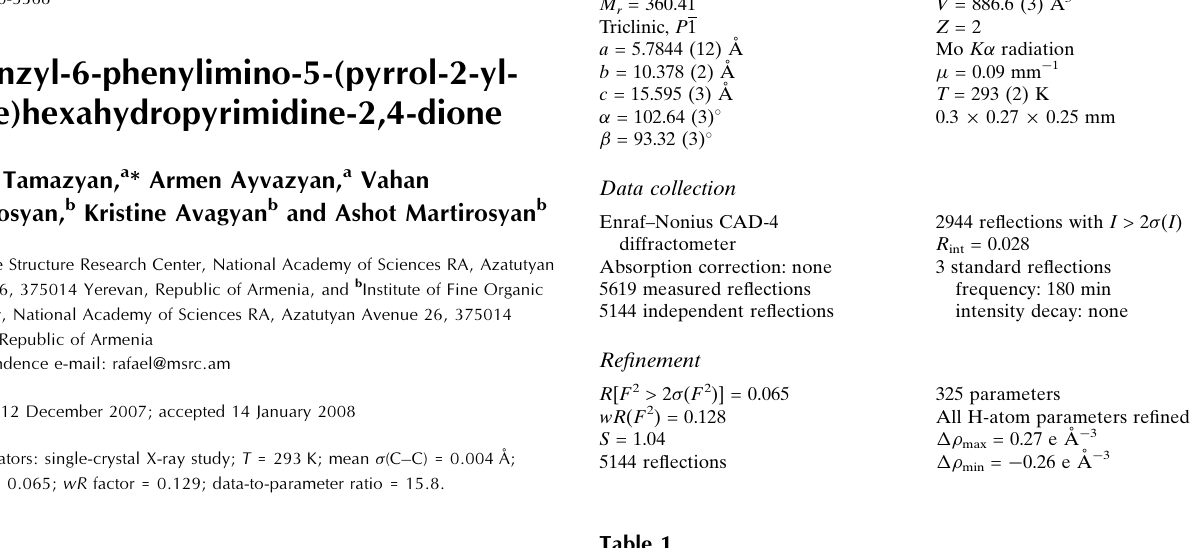
Hydrogen-bond geometry (A˚ , (cid:2)